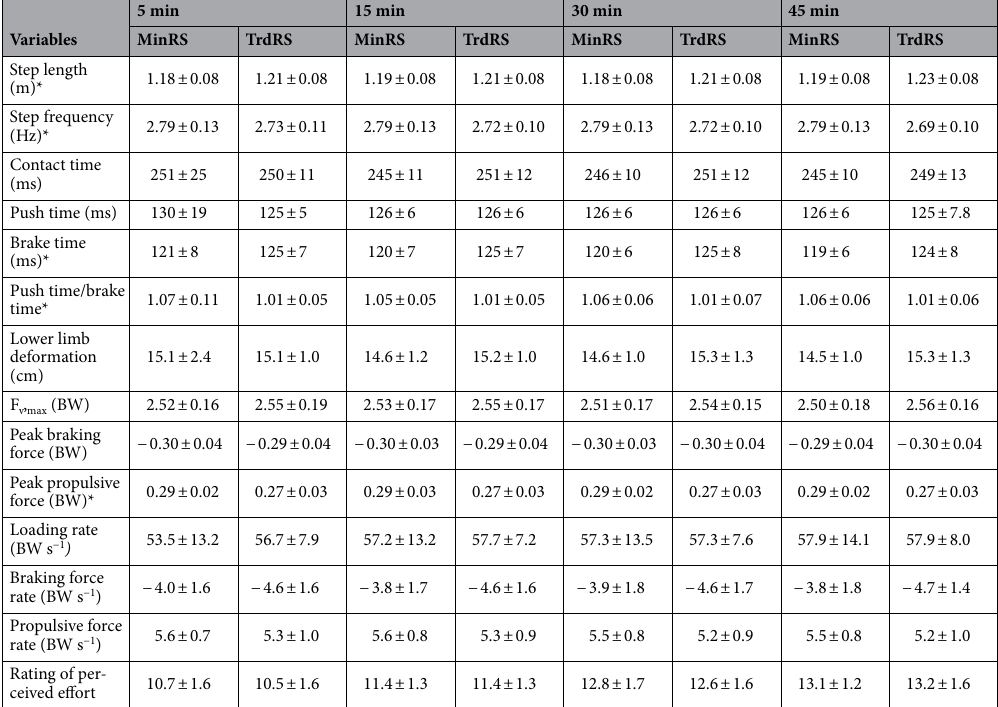
Table 2. Spatiotemporal parameters, maximal vertical, braking and propulsive forces and loading, braking and propulsive rates and rating of perceived effort. Values are mean ± SD (n = 16). F v,max , maximal vertical force; BW, body weight. * indicates a significant difference between conditions ( P ≤